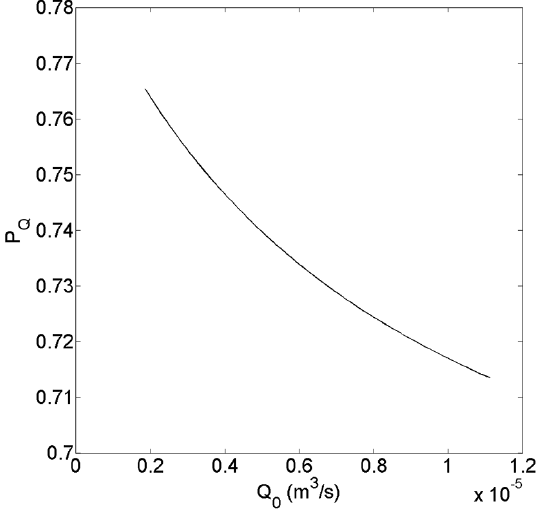
Figure 4. Probability of water distribution evaluated for main path P Q versus injection flow rate Q 0 (m 3 s − 1 ).